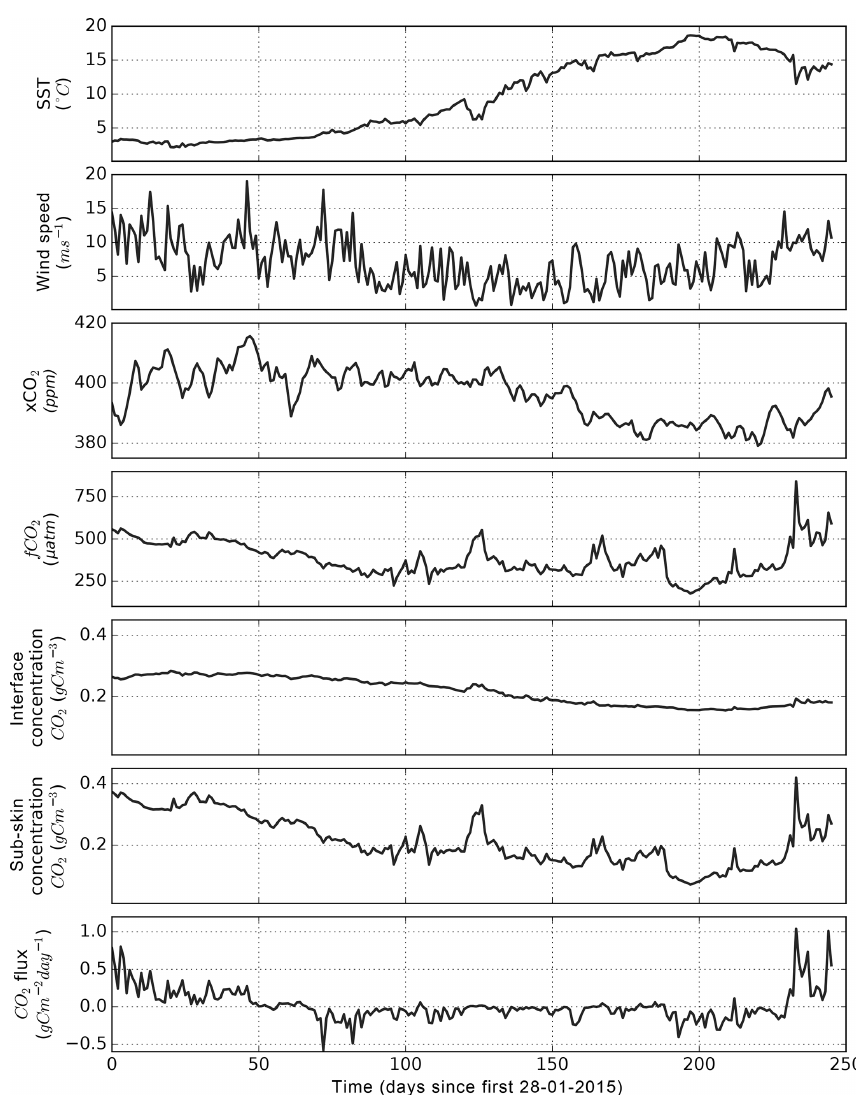
Figure 5. FluxEngine output file using data from Östergarnsholm station over the 246d period. Example components of the sea-to-air flux calculation are shown alongside the calculated CO 2